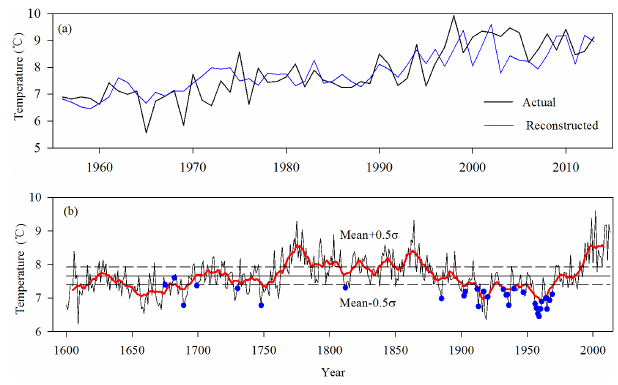
Figure 6. (a) Actual (black line) and reconstructed (blue line) April–July minimum temperature for the common period of 1956– 2013; (b) reconstruction of April–July minimum temperature on Laobai Mountain for the last 414 years. The smoothed line indi- cates the 11-year moving average, and blue dots represent minimum freezing events.